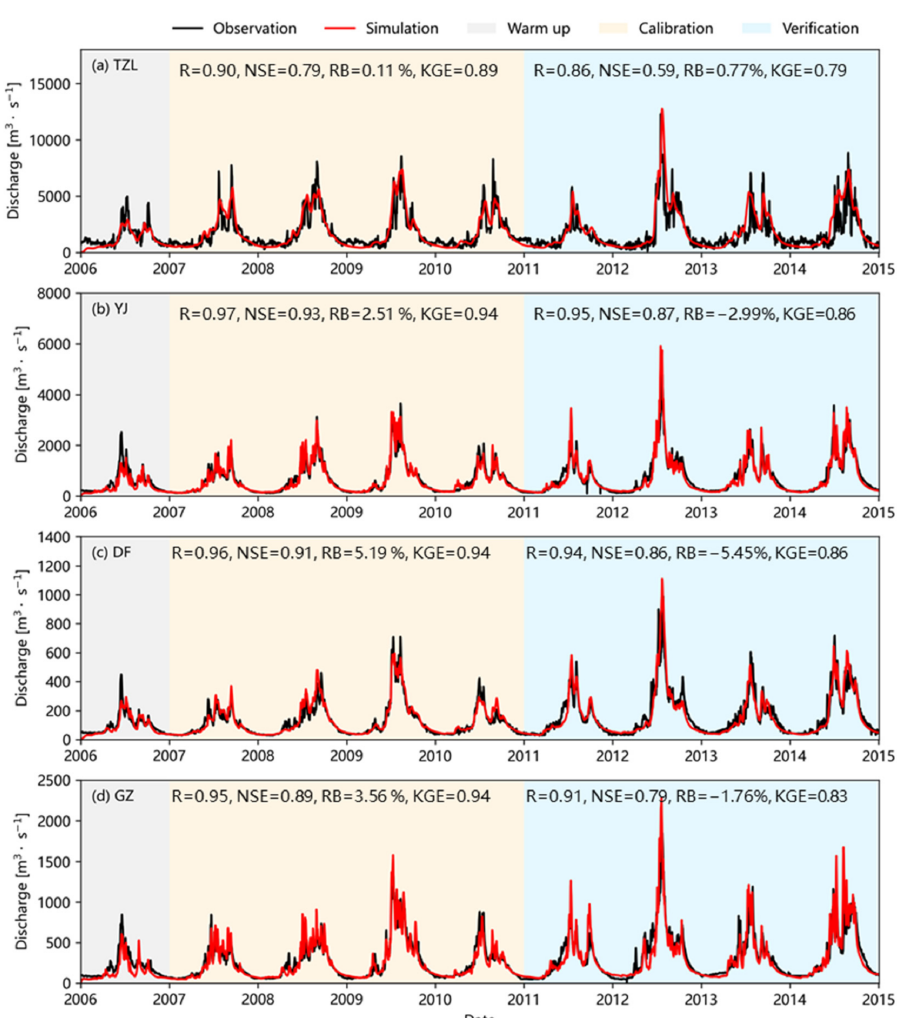
Figure 3. Model calibration and verification at four hydrological stations. ( a ) TZL. ( b ) YJ. ( c ) DF. ( d ) GZ. Pearson correlation coefficient (R); Nash–Sutcliffe efficiency (NSE); Kling–Gupta efficiency (KGE); Relative bias